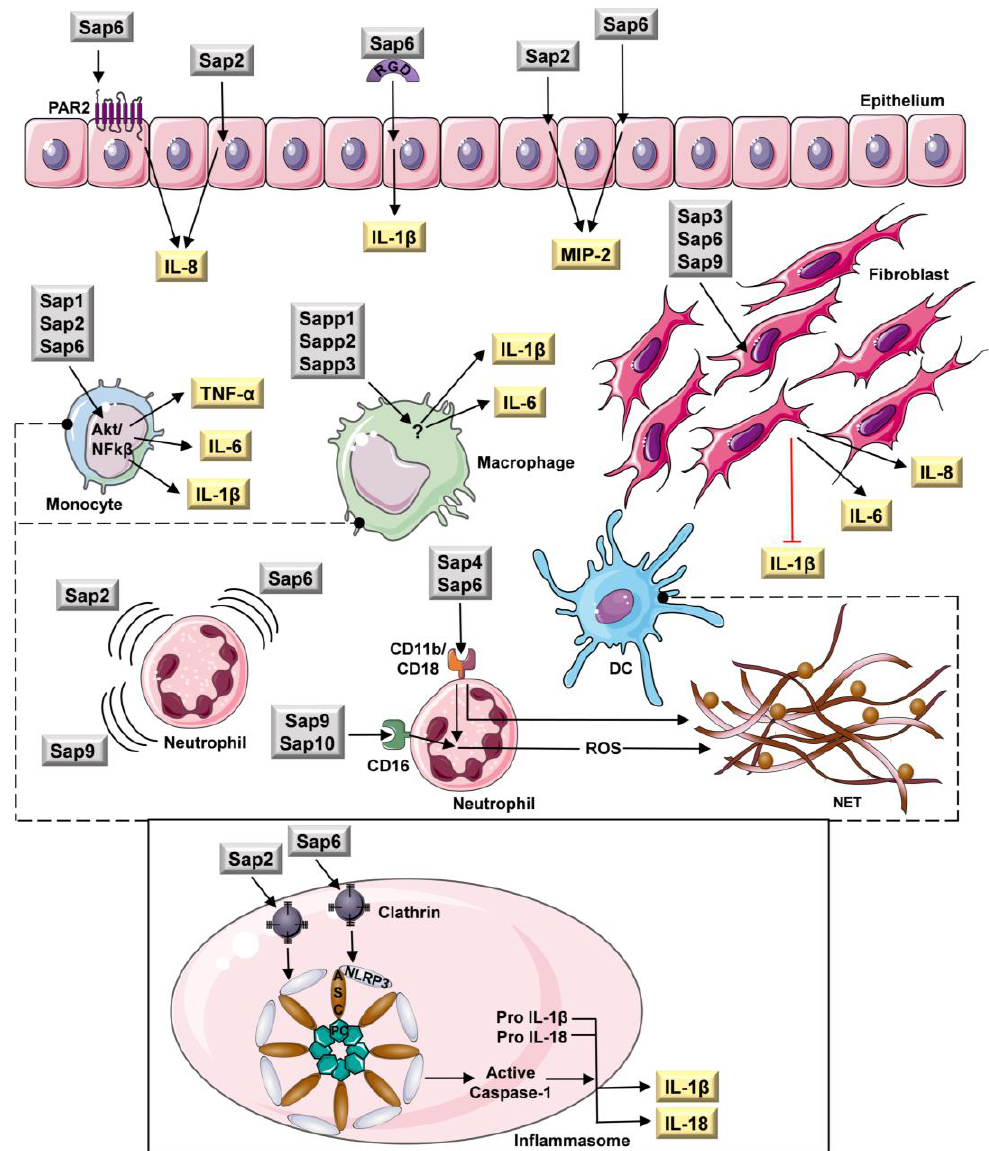
Figure 3. Multitasking of Candida spp. extracellular proteases in relation to the host immune cells. The figure was partly generated using Servier Medical Art, provided by Servier, licensed under a Creative Commons Attribution 3.0